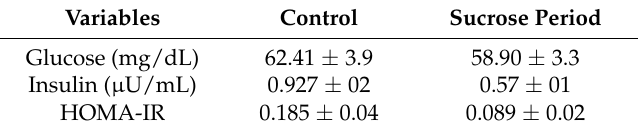
Table 2. Glucose, insulin and insulin resistance in control and sucrose period rats ( n = 6).